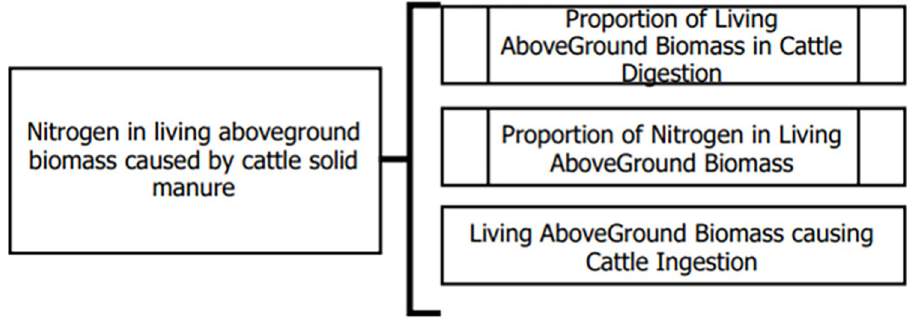
Fig 5. Dataflow of “Nitrogen in living above ground biomass caused by cattle solid manure” model (excretion namespace). “Nitrogen in living above ground biomass caused by cattle solid manure” is composed of three models related to namespaces of livestock mass, nitrogen and